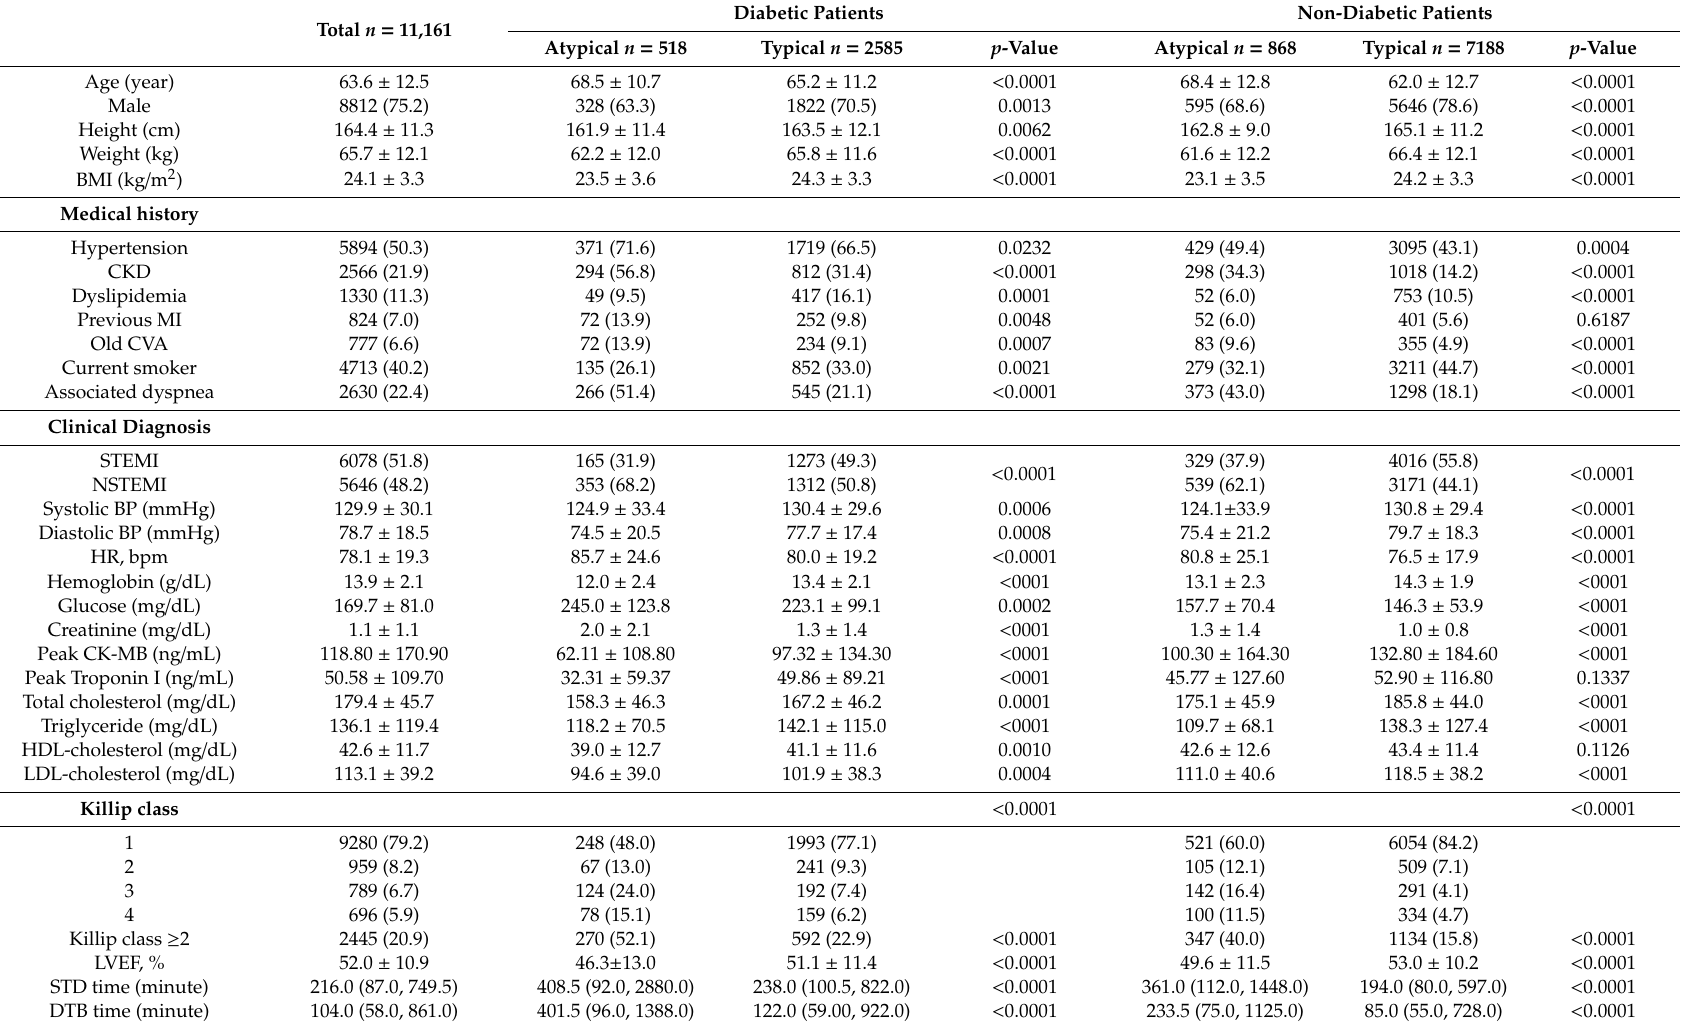
Table 1. Baseline